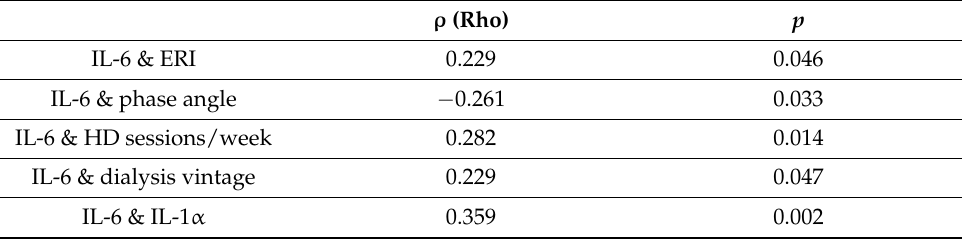
Table 6. Association of IL-6 levels, body composition, biochemical parameters and dialysis-related data; n = 78.